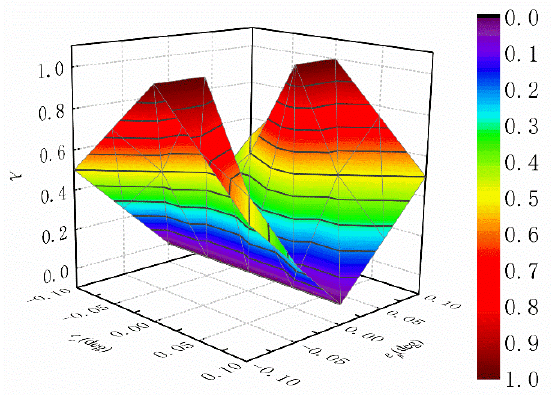
Figure 5. The three-dimensional surface of the weight coefficient λ .